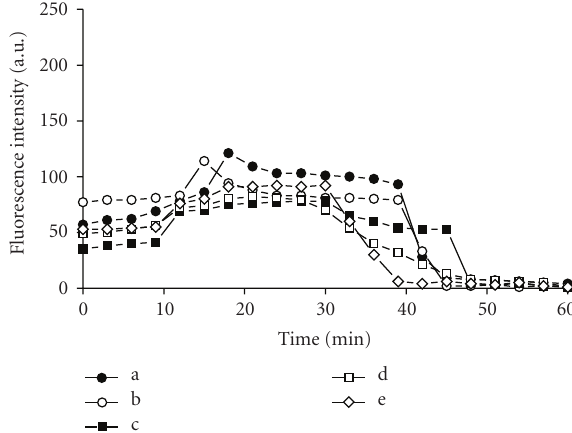
Figure 2: Kinetics of changes in the concentration of intracellular calcium in cell a, b, c, d, and e of Figure 1 before and after treated with 2.0 mM